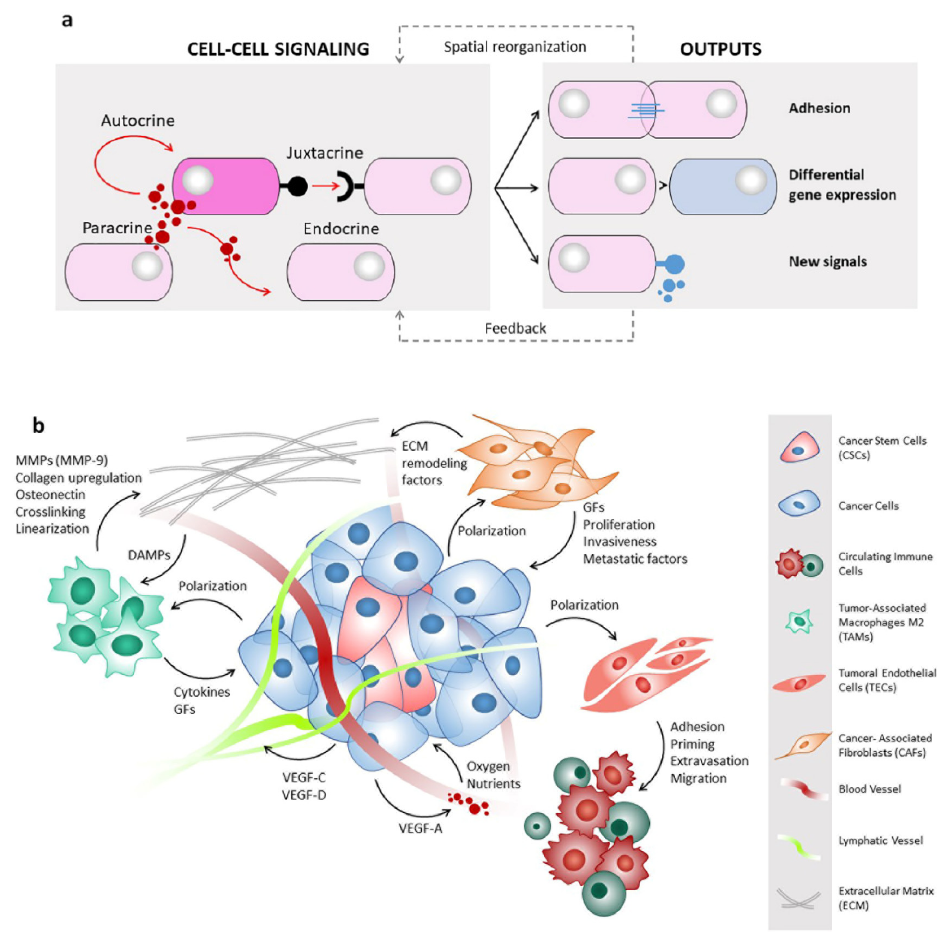
Figure 3. Types of cell–cell interactions and communications in tumour microenvironment. ( a ) Cells communicate through various types of signalling that allow chemicals to travel to target sites in order to elicit a biological response. In autocrine signalling, cells produce ligands that induce a cellular response through cognate receptors for those molecules expressed in the same cell. Paracrine signalling depends on the local diffusion of secreted molecules from one cell to other neighbouring cells. In contrast, cell–cell contacts are required for iuxtacrine signalling, where molecules directly pass between cells via gap junctions or other structures without secretion into the extracellular space. In endocrine signalling, molecules are secreted and travel long distances through extracellular fluids such as the blood plasma to reach target cells and tissues; typical mediators of this communication are hormones. The action of signalling molecules on target cells triggers new downstream signalling, modifies gene expression, and influences cell–cell adhesive properties and spatial organization. In response to these changes, feedback mechanisms can be activated to maintain cell/tissue homeostasis. ( b ) Multiple cell types are present in the tumour microenvironment, and all of them contribute to the maintenance of the complex and dynamic network of signalling molecules characterizing the peritumoral niche. Tumours and cancer stem cells (CSCs) produce angiogenic and lymphangiogenic factors (VEGF-A and VEGF-C/D, respectively), and in turn, blood vessels deliver nutrients and oxygen. In addition, tumours and CSCs secrete molecules able to induce the acquirement of a pro-tumoral phenotype, i.e., able to polarize macrophages to M2 subtype, fibroblasts to CAFs, and ECs to TECs. All these cell types drive cancer cell proliferation, invasion, and metastasis through the production of growth factors, cytokines, and ECM remodelling enzymes.